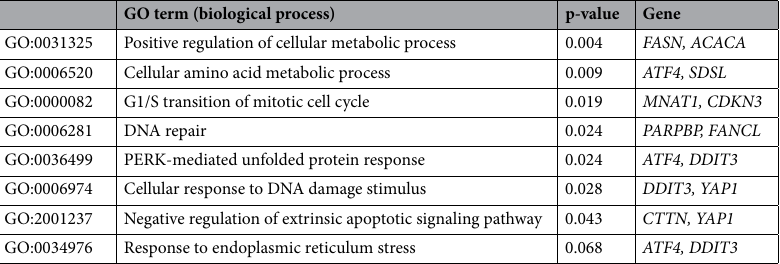
Table 2. GO enrichment analysis of differentially expressed genes by JPH203 treatment in T-47D